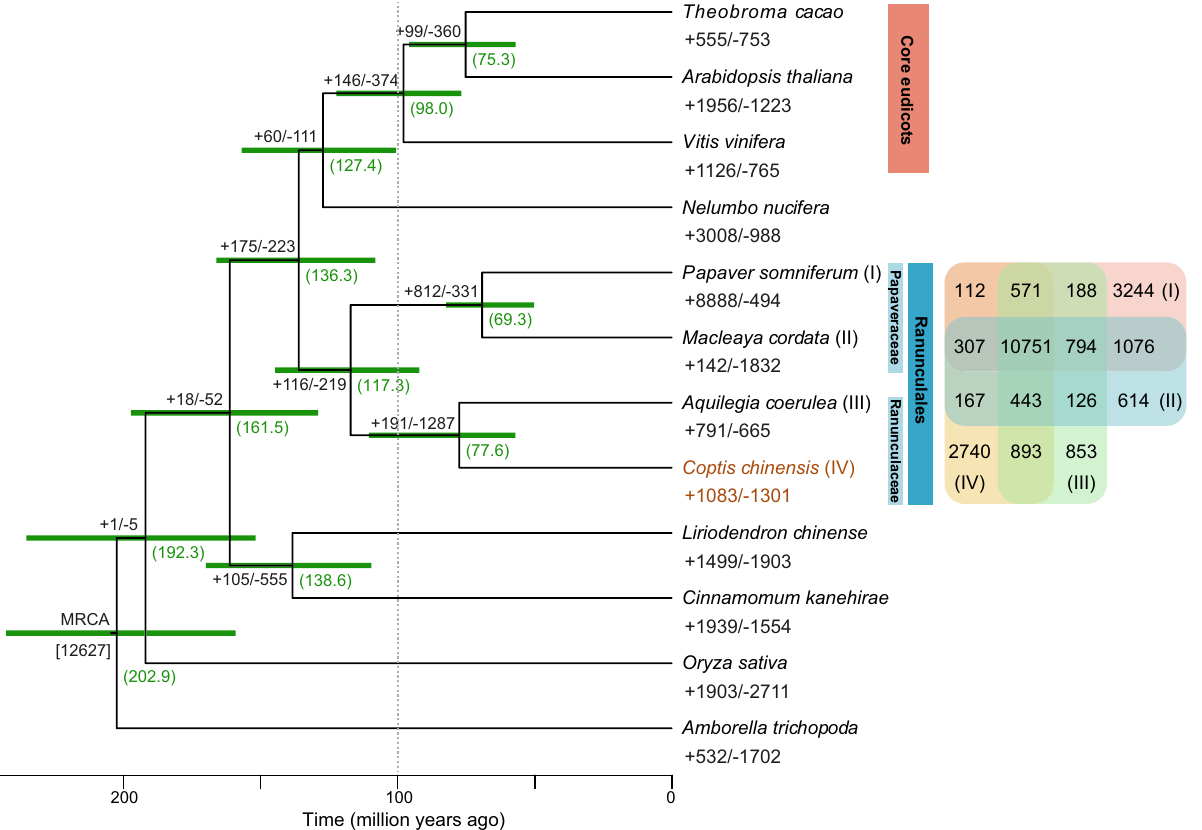
Fig. 2 Species tree comprising 12 angiosperm species, including Coptis chinensis . Expansion and contraction of gene families are denoted as numbers with plus and minus signs, respectively. The green numbers in the brackets indicate the estimated divergence time of each node, and the green bars show the 95% con fi dence interval of divergence time, in millions of years. All the nodes are 100% bootstrap support. A Venn diagram at the side of the tree shows the sharing and speci fi city of gene families presented between four Ranunculales